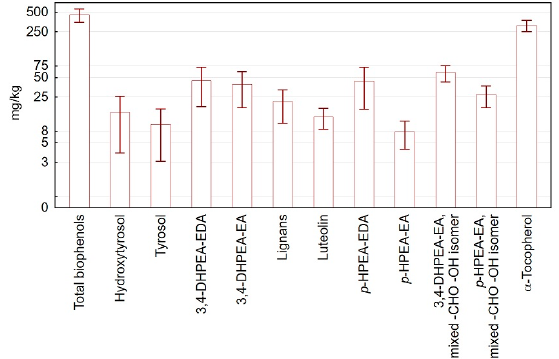
Figure 3. Histograms of the analyzed biophenols averaged for all samples. Bars represent standard deviations. A logarithmic scale was used on the Y axis.